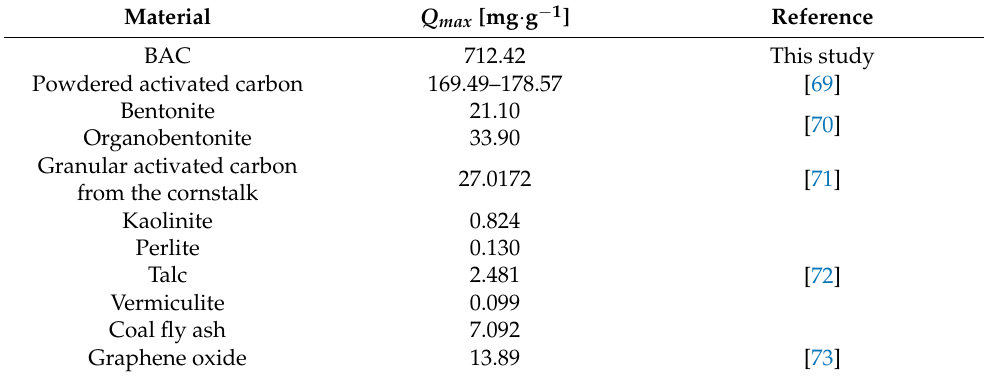
Table 9. Maximum adsorption capacity of isoniazid by some adsorbents described in the literature.